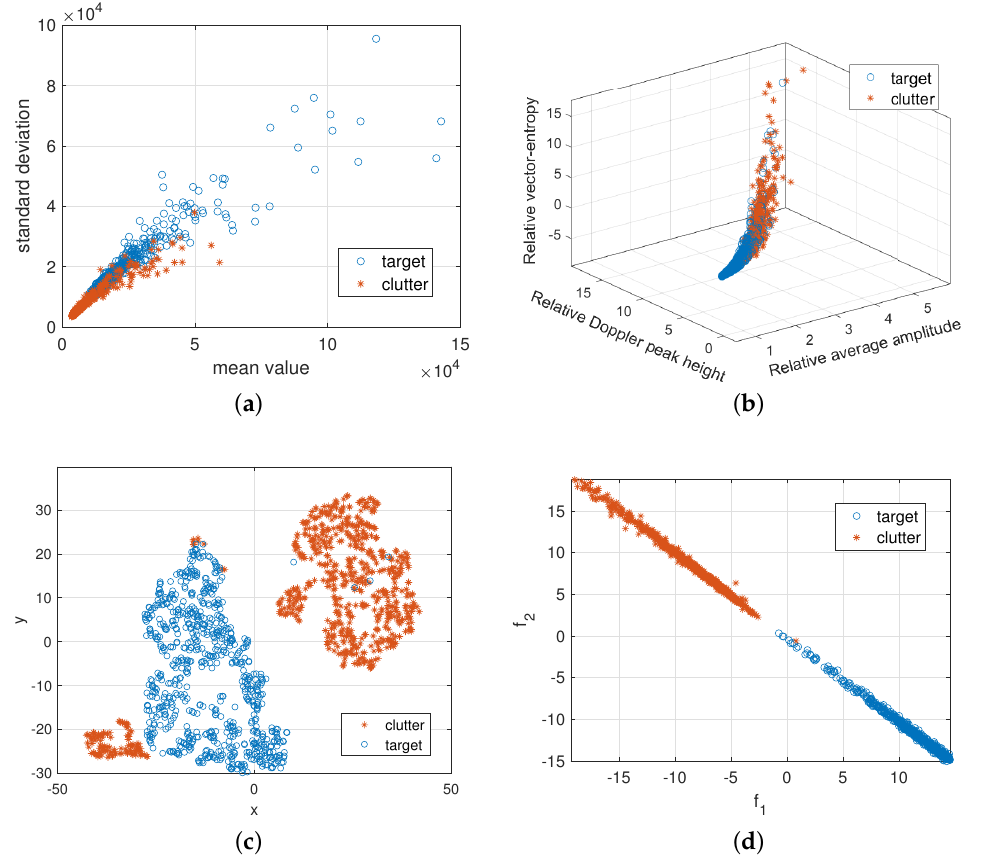
Figure 9. Separability of clutter and target feature. ( a ) Numerical characteristics of the amplitude. ( b ) Distributions of features in the 3D feature space. ( c ) T-SNE visualization of HOG. ( d ) Extraction characteristics of time-frequency